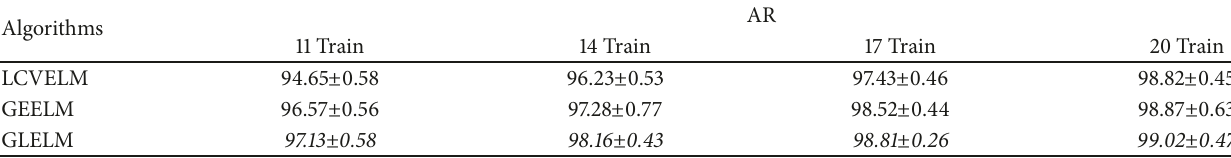
Table 5: Classification accuracy (mean ± std%) of different methods with different numbers of training samples on the AR database. Algorithms